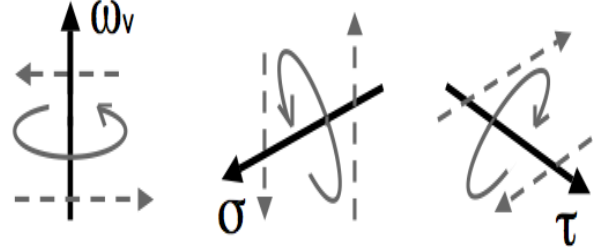
Fig. 3. Scheme of the vertical vorticity ω v , generated by the hori- zontal shears of the horizontal velocity, and the two components of the horizontal vorticity σ and τ generated respectively by horizontal shears of the vertical velocity and vertical shears of the horizontal